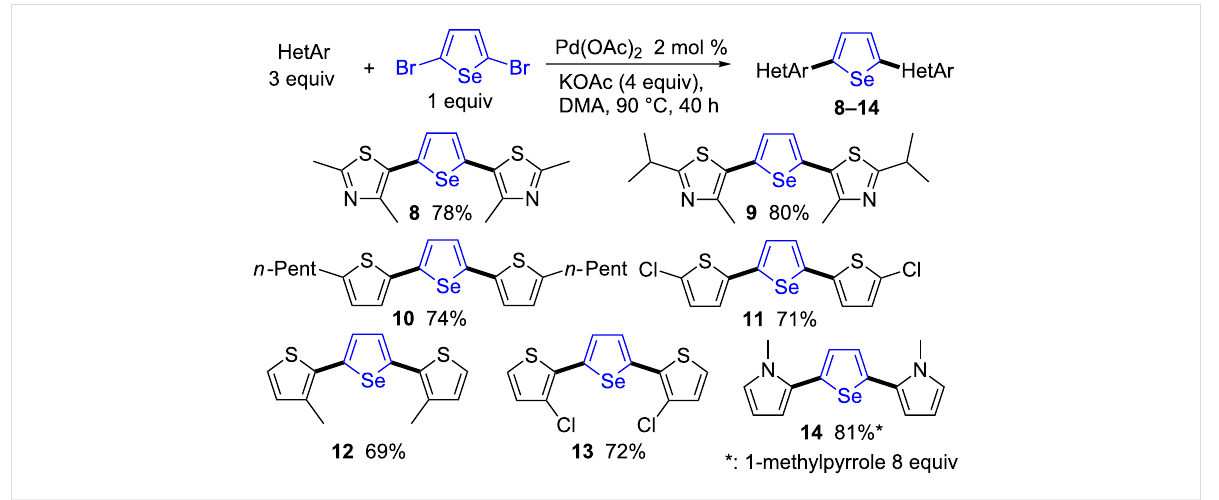
Scheme 3: Palladium-catalyzed 2,5-diheteroarylation of 2,5-dibromoselenophene.